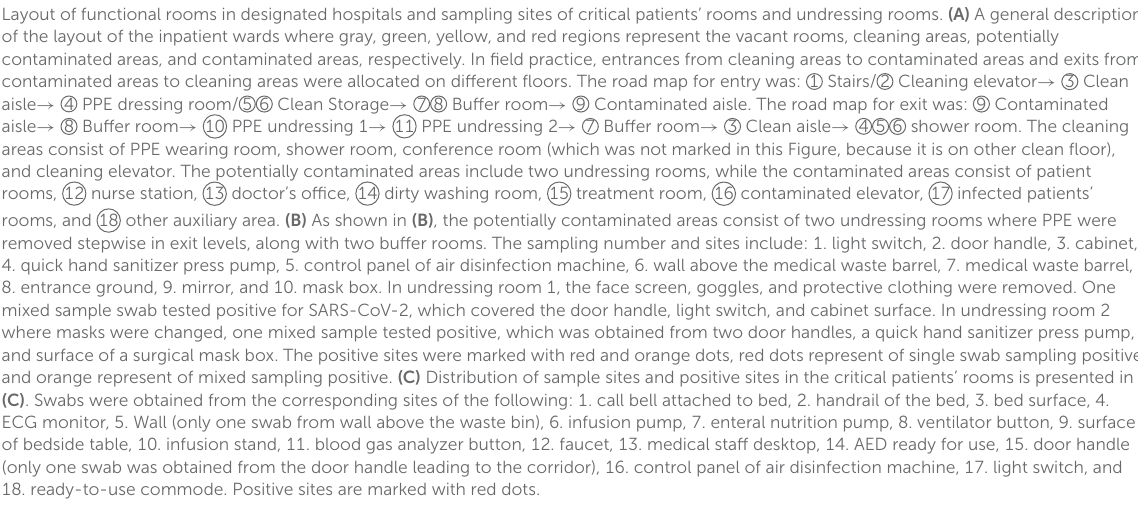
Figure 1. We conducted daily monitoring of